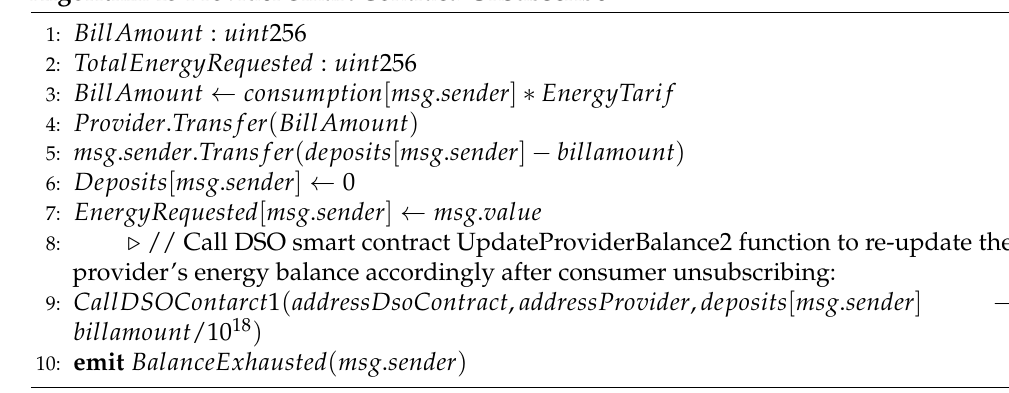
Algorithm 13 Provider Smart Contract: